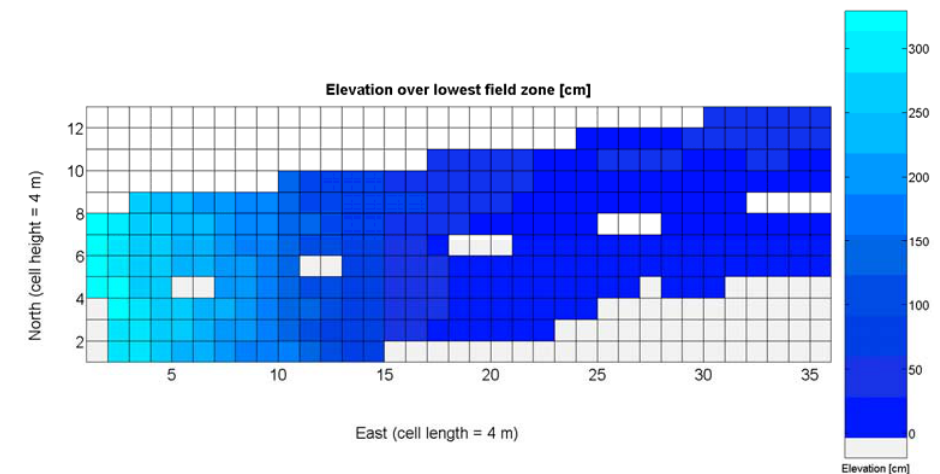
Figure 6. CB map of field relative elevation (cm).